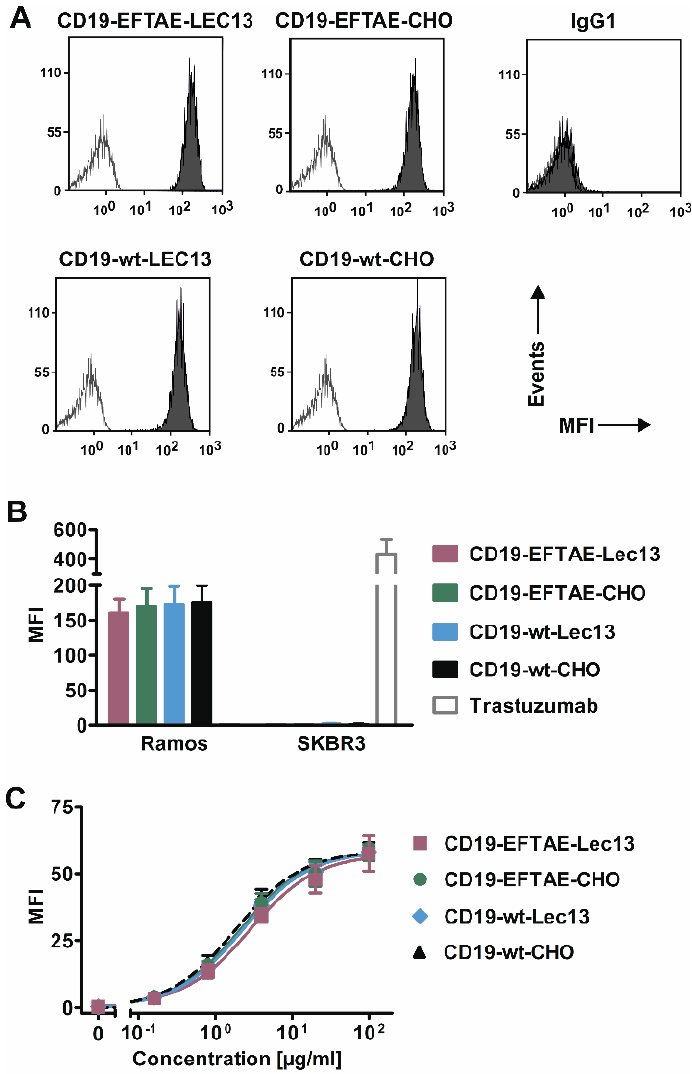
Figure 2. CD19 binding analysis. ( A ) CD19-positive Ramos cells were incubated with antibodies as indicated (concentration: 50 µg/mL; grey peaks) or in PBA buffer alone (white peaks), stained with FITC-coupled anti-human IgG Fc F(ab’)2 and then analyzed by flow cytometry. As a control, trastuzumab was added (IgG1). ( B ) CD19-wt-CHO, CD19-EFTAE-CHO, CD19-wt-Lec13 and CD19-EFTAE-Lec13 (concentration: 50 µg/mL) bound to CD19-expressing Ramos cells but did not react with CD19-negative SK-BR-3 cells. Bars indicate mean values ± SEM ( n = 3) of mean fluorescence intensity (MFI). PE-labeled anti-human IgG Fc F(ab’)2 fragments were used as secondary antibodies. Trastuzumab was employed as a control antibody and bound to HER2-positive SK-BR-3 cells. ( C ) Binding of antibody versions to CHO-K1-CD19 cells was analyzed at varying concentrations employing FITC-coupled anti-human IgG Fc F(ab’)2 fragments as detection reagents and MFI values were determined by flow cytometry. Mean values ± SEM are shown ( n = 4).